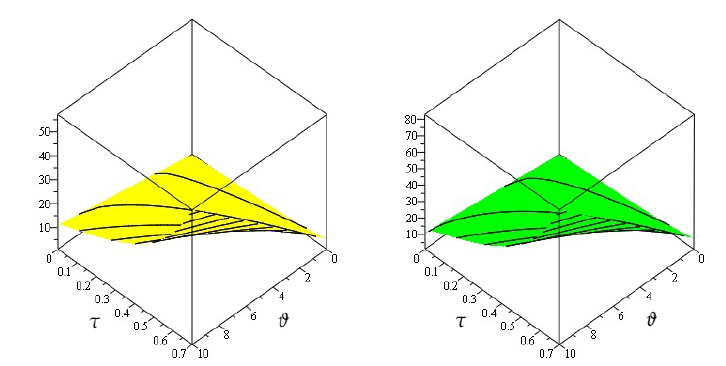
Figure 5. The analytical solutions of ν ( ϑ , ζ , z , τ ) at (cid:36) = 0.6 and 0.4 of Example 2.